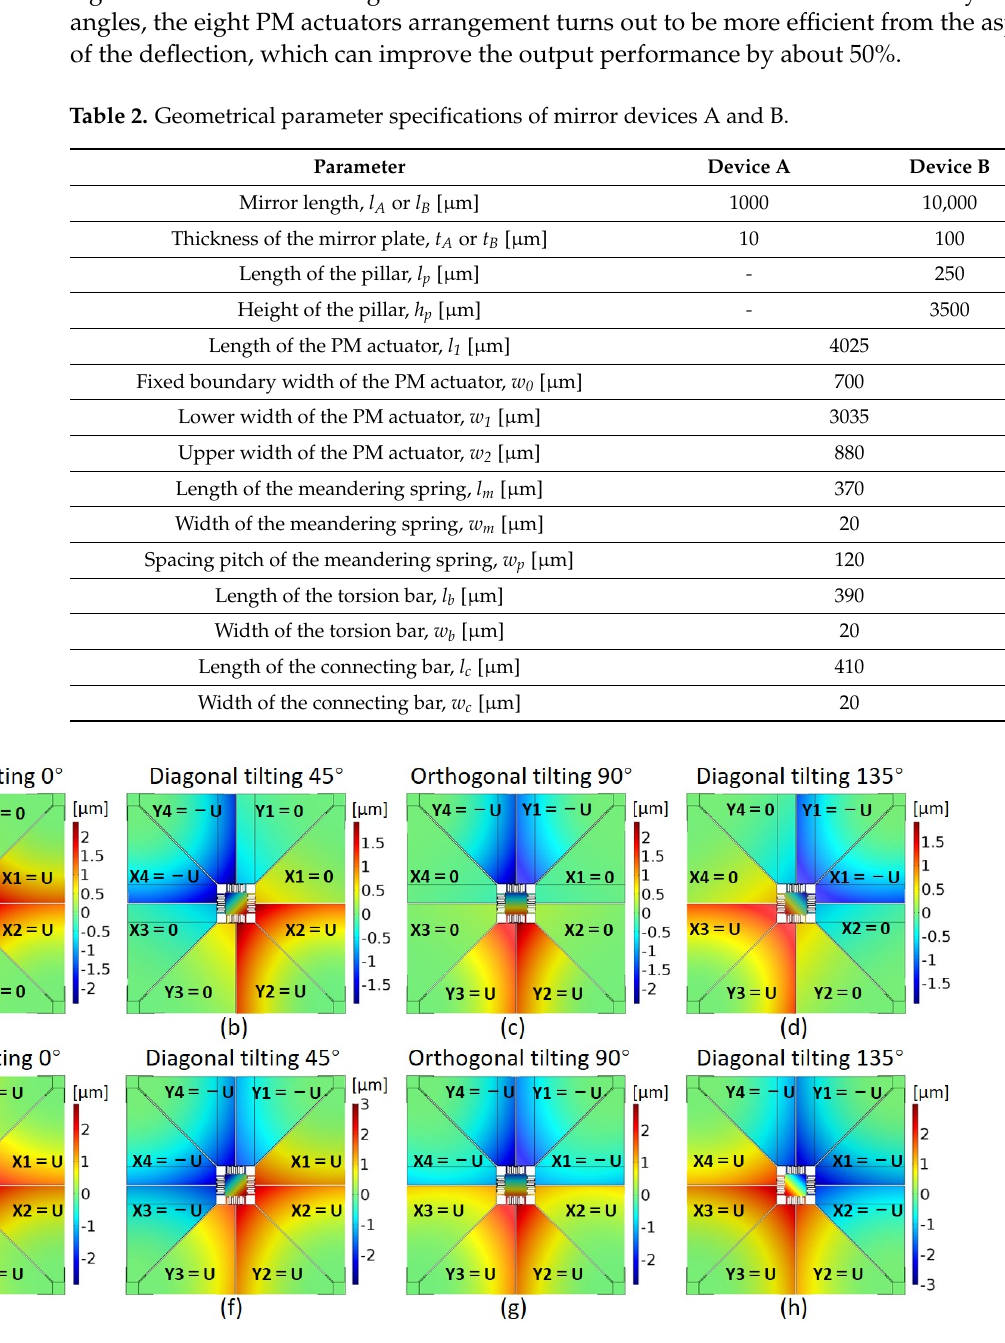
Figure 2. Mirror actuation principle for ( a – d ) 0°, 45°, 90° and 135°tilting angles when only using four PM actuators; ( e – h ) 0°, 45°, 90° and 135°tilting angles when using eight PM actuators.